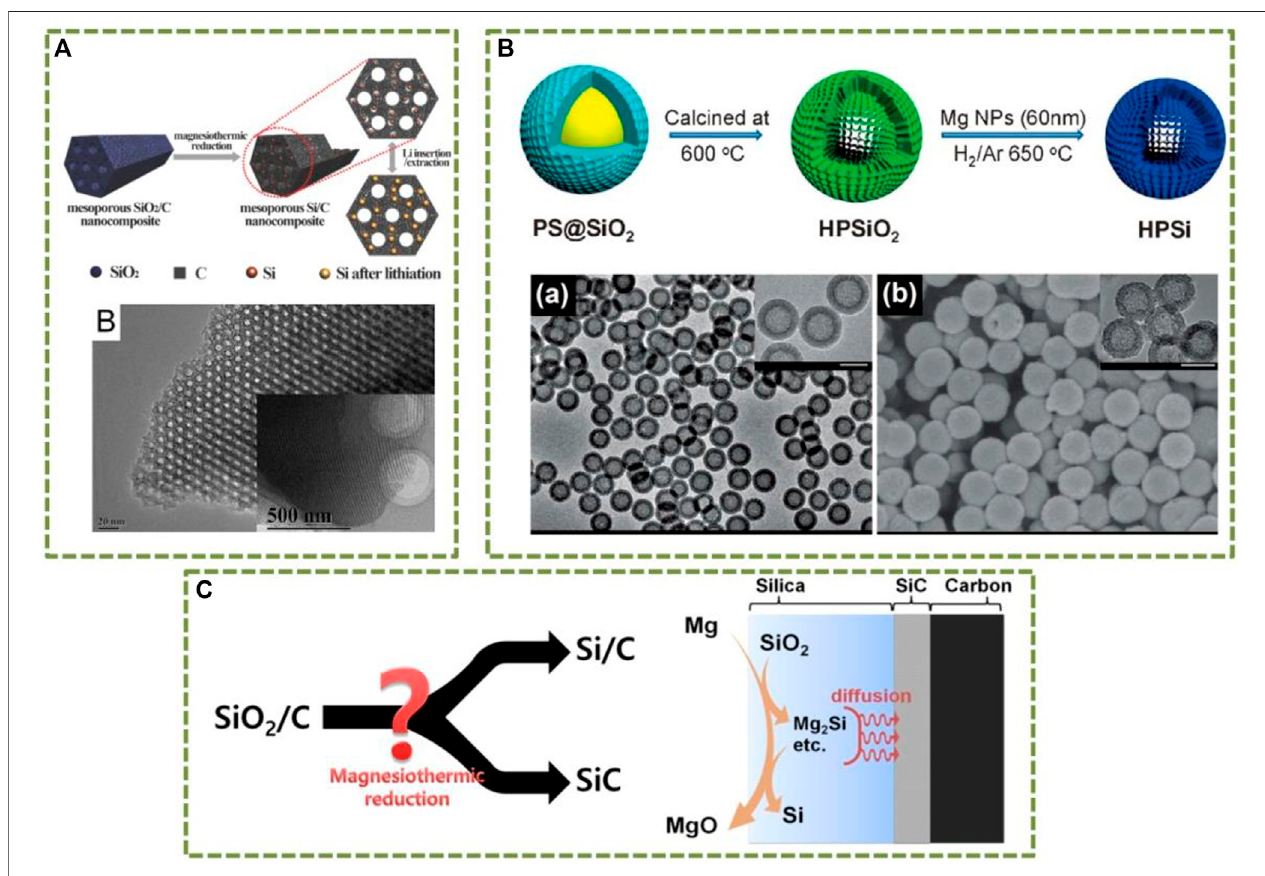
FIGURE1| Representativeworksfortheproduction ofSinanomaterialswithmagnesiumthermalreduction (A) (Zhangetal.,2014); (B) (Chen etal.,2012)and (C) Ahn et al., 2016. Reprinted with permission. Copyright © 2014, 2012 WILEY-VCH Verlag GmbH and 2016 American Chemical Society.